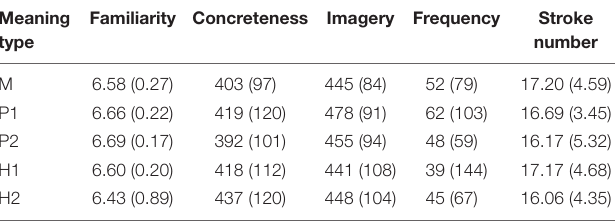
TABLE 1 | The lexical properties of the five sets of Chinese meanings, mean (SD). Meaning Familiarity Concreteness Imagery Frequency type